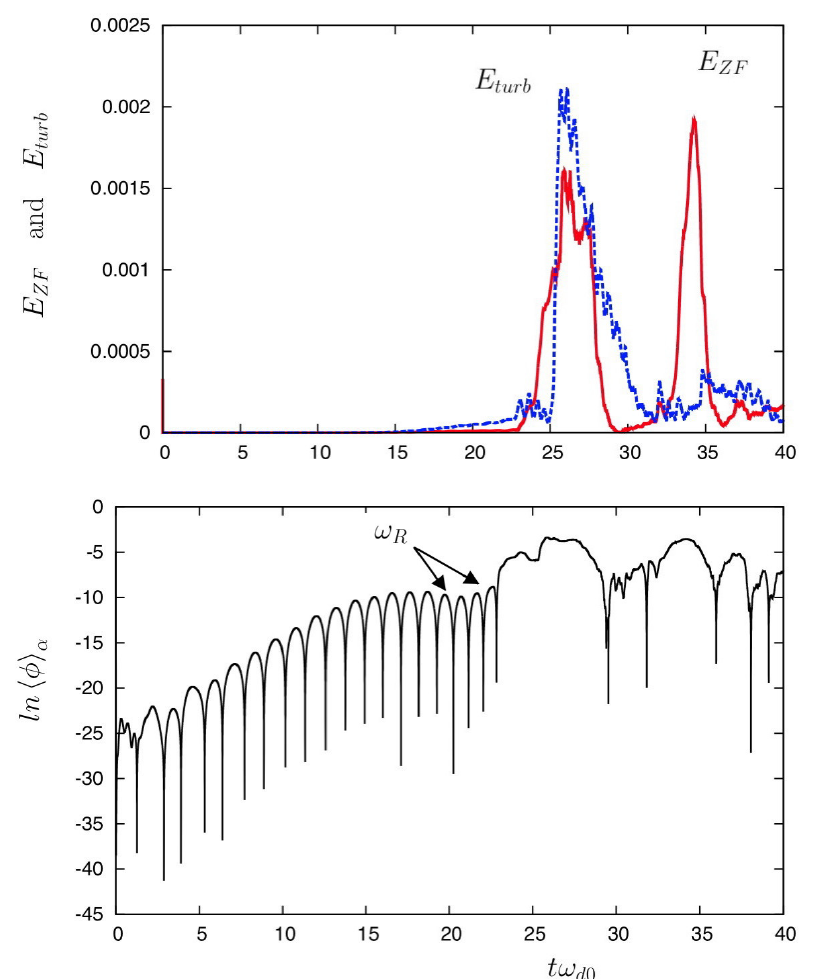
Figure 8. Plot of the turbulent energy E turb (shown in the dotted and blue line) in the kinetic regime. In the bottom panel, the time evolution of the squared mean potential (cid:104) φ (cid:105) in a logarithmic scale. There α is a qualitative change in the interchange turbulence, which exhibits a weaker simultaneous growth of E ZF and E turb until saturation, at time t ω d 0 (cid:39) 25, and an oscillatory behavior of (cid:104) φ (cid:105) at low frequency. α Here, the physical parameter is C i = 1.25. In the saturation phase of the instability, zonal flow (ZF) (cid:39) 3.1 ω n (cid:104) ω d ( κ ) (cid:105) features linear trapped ion modes (TIMs) (with a frequency ω R = 3 d 0 with no κ 2 frequency shift. The plot of (cid:104) φ (cid:105) was taken at ψ = 1 (in (cid:52) ψ α 2